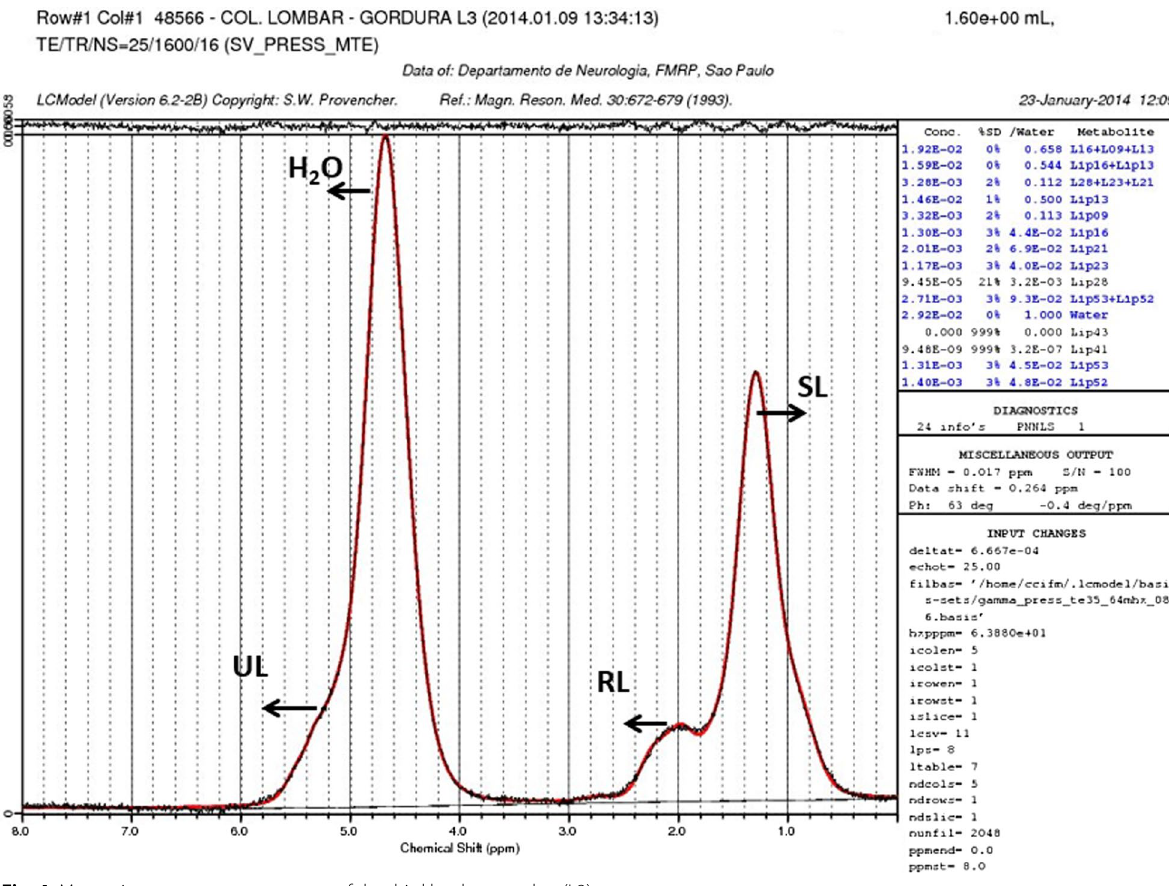
Fig. 4 Magnetic resonance spectroscopy of the third lumbar vertebra